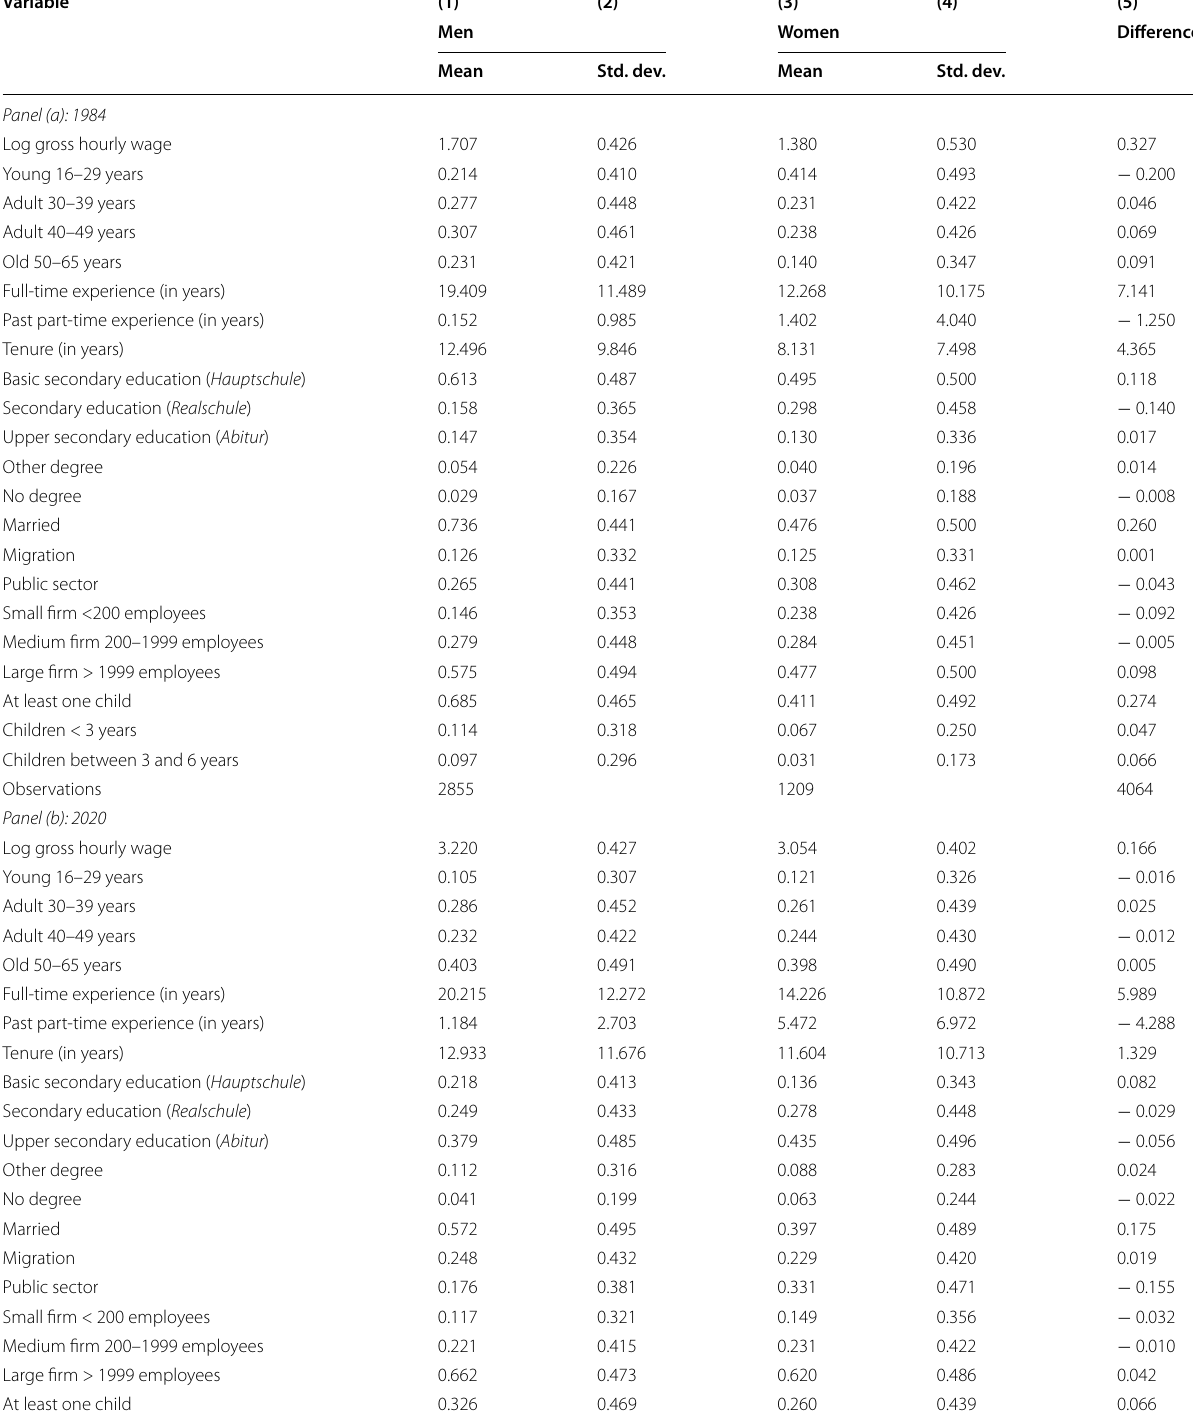
Table 1 Descriptive statistics for men and women in 1984 and 2020, selected controls